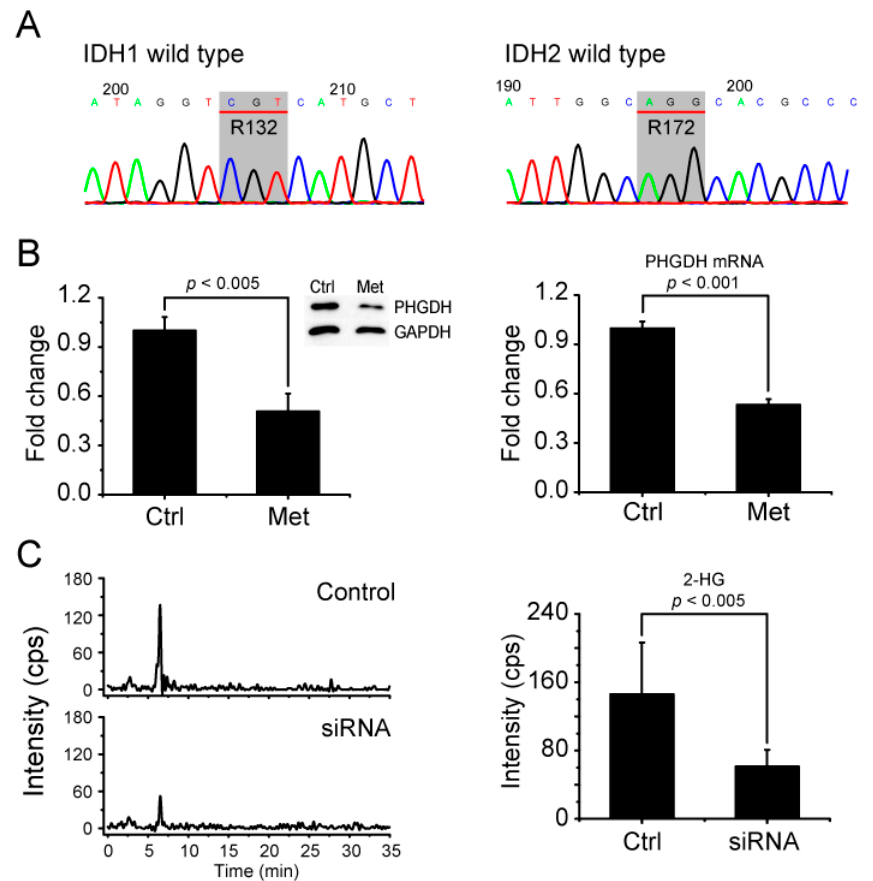
Figure 4. Metformin inhibits 2-HG production by PHGDH in MCF-7 cells without IDH mutations. ( A ) DNA sequencing against IDH1 R132 and IDH2 R172 residues was performed using genomic DNA from MCF-7 cells. Codons for IDH1 R132 and IDH2 R172 are indicated in gray boxes as CGT and AGG encoding Arginine. ( B ) The PHGDH level after metformin treatment was measured for protein (left) and mRNA (right) by Western blot and real-time PCR, respectively. ( C ) The alteration of the 2-HG level by PHGDH siRNA was measured with LC/MS. The data are from five independent experiments. The error bars represent the standard deviation.